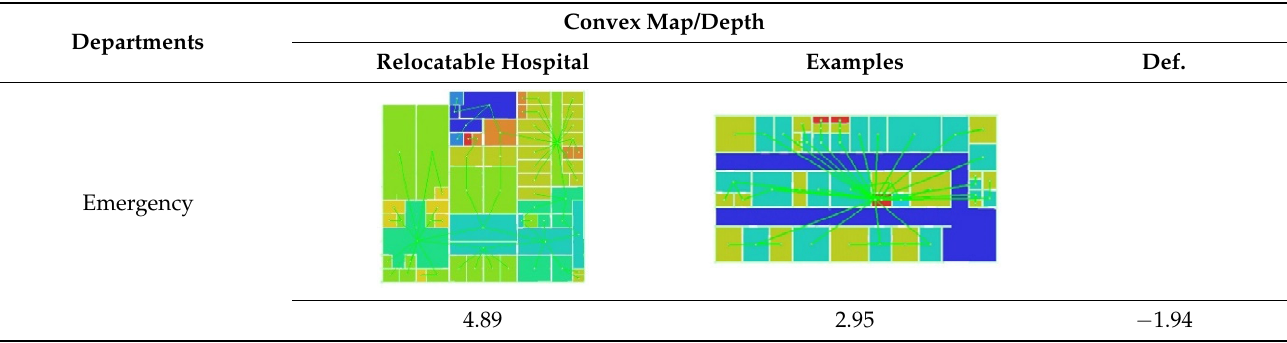
Table 16. Convex map analysis/depth values and graphs of the case study departments compared to examples.